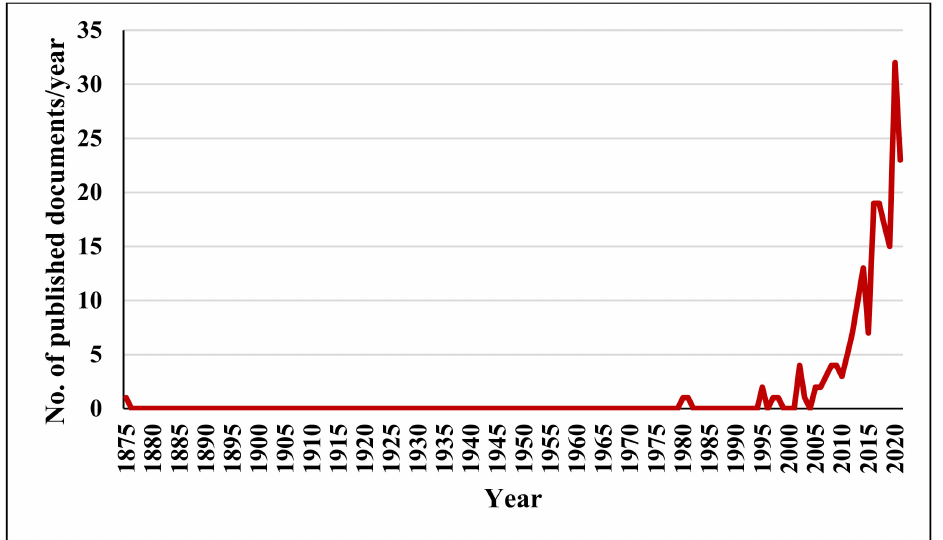
Figure 4. Evolution of publications on IWSSs with a timeframe from the beginning of 1875 to 1 October